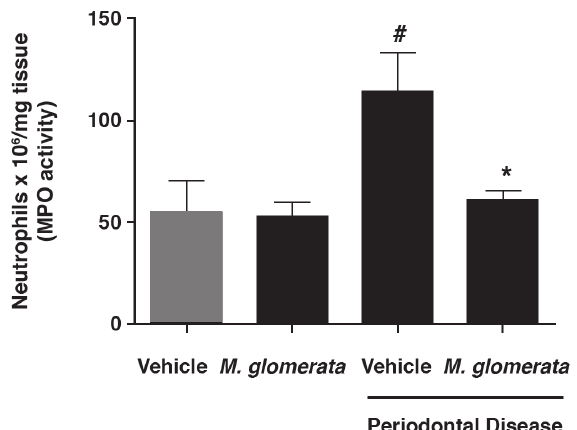
Figure 2- Mikania laevigata extract (MLE) decreases neutrophil migration to the gingival tissue. In order to estimate the relative numbers of infiltrating neutrophils